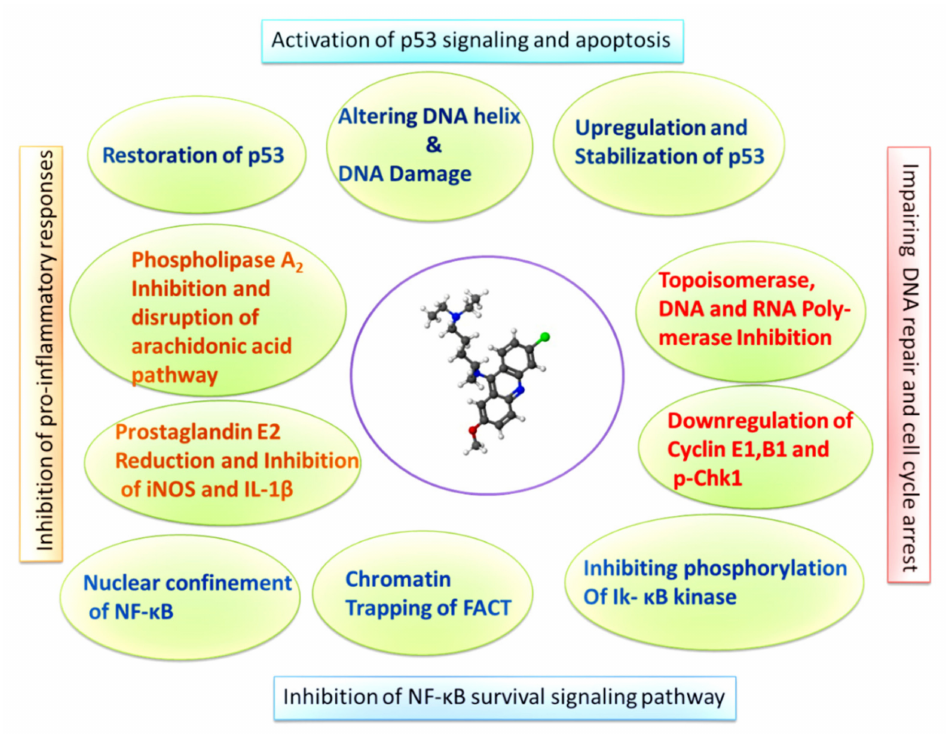
Figure 1. Graphic describing the molecular mechanisms of NF- κ B inhibition, p53 induction, and cell cycle arrest induced by QC in cancer